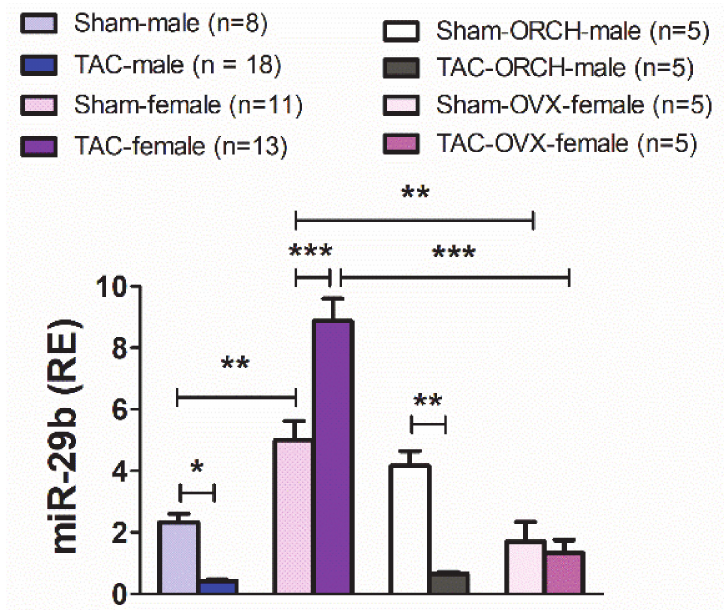
Figure 1. Relative expression (RE vs. RNU6b) of miR-29b in the LV from male, female, orchiectomized (ORCH) male and ovariectomized (OVX) female mice subjected to a 4-week transverse aortic constriction (TAC) or sham (no-TAC) surgery. Data are expressed as mean ± SEM. * p < 0.05, ** p < 0.01, *** p < 0.001 (two-way ANOVA followed by Bonferroni post hoc